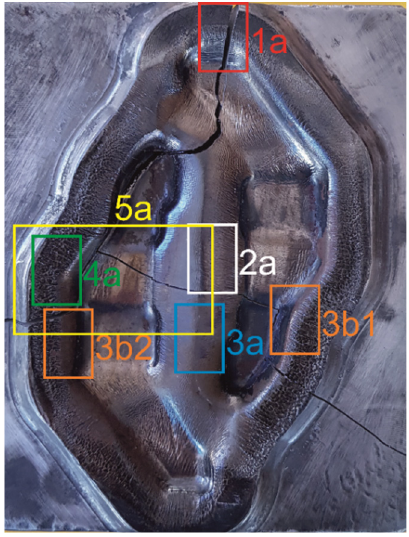
Figure 3. The pre-forming die insert with areas selected for analysis.